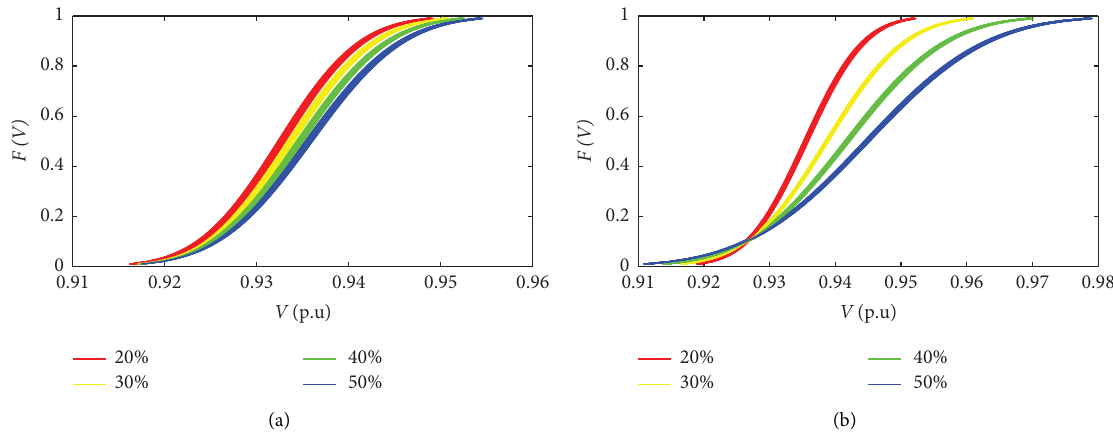
Figure 10: Te CDF curves of V